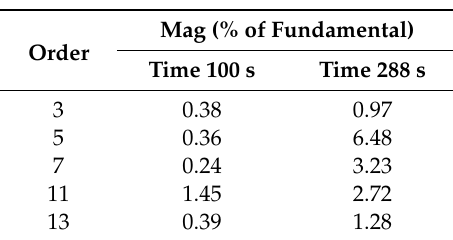
Table 3. Main current harmonics.